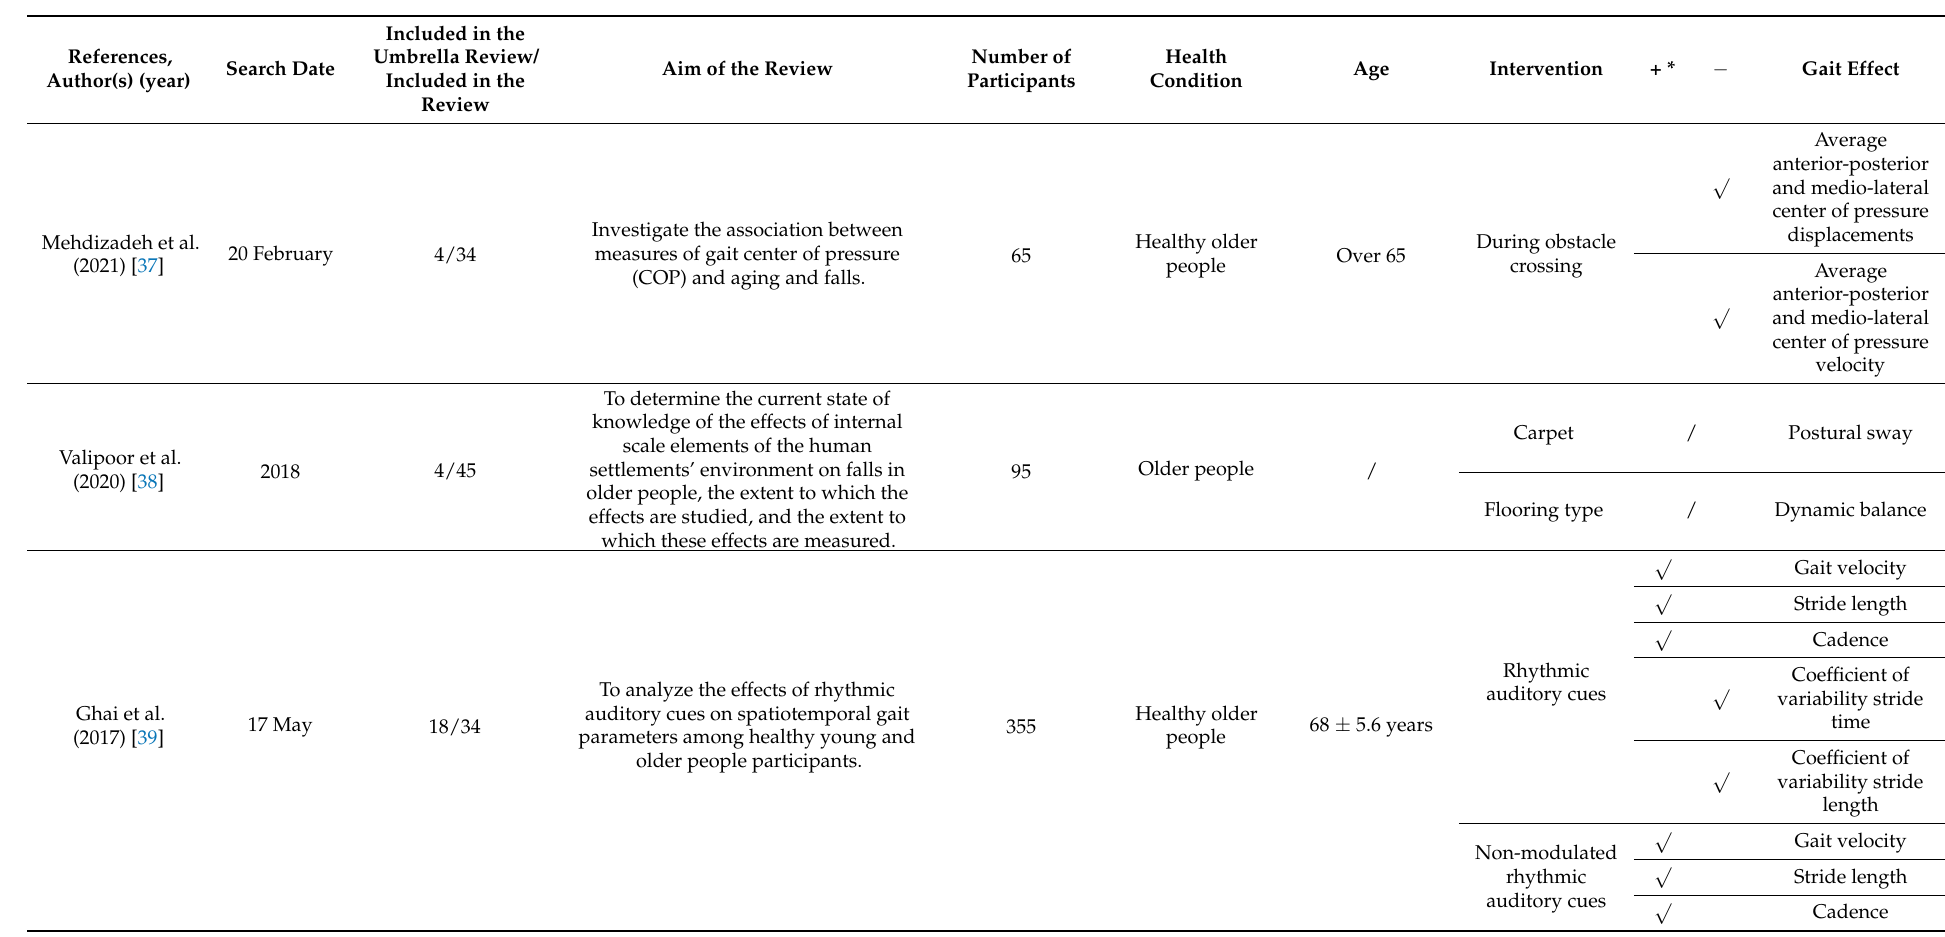
Table 2. Basic features of